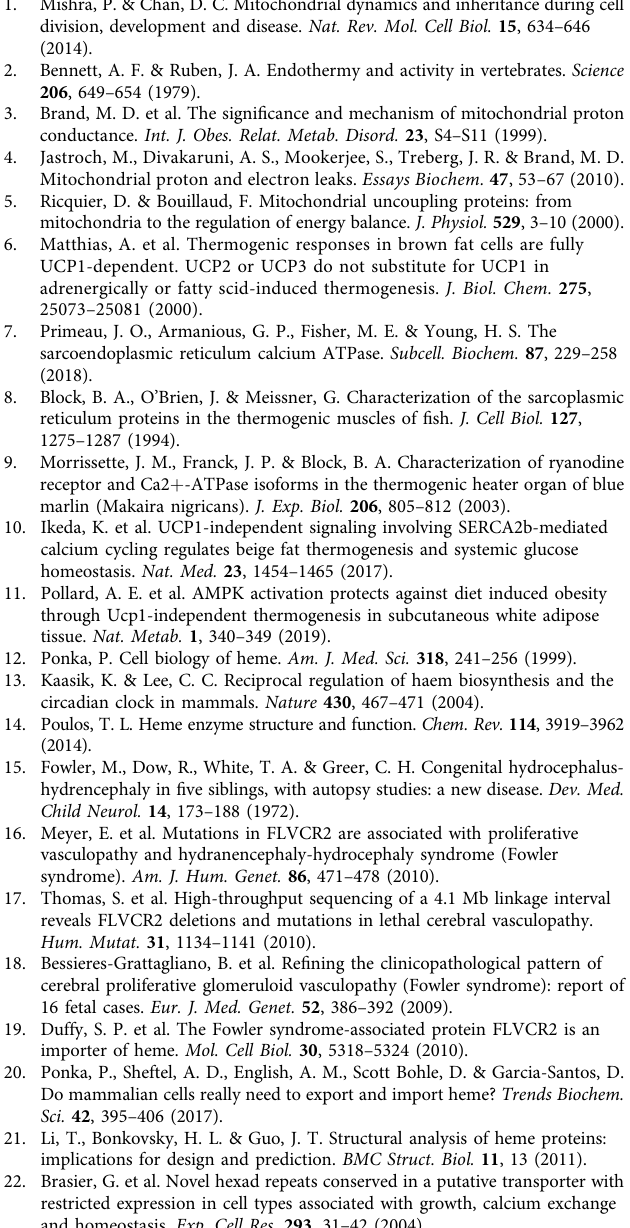
Figure illustrations . Certain images were used from the Library of Science and Medical Illustrations to create illustrations in Fig. 6a, b, and Supplementary Fig. 7a,c 51